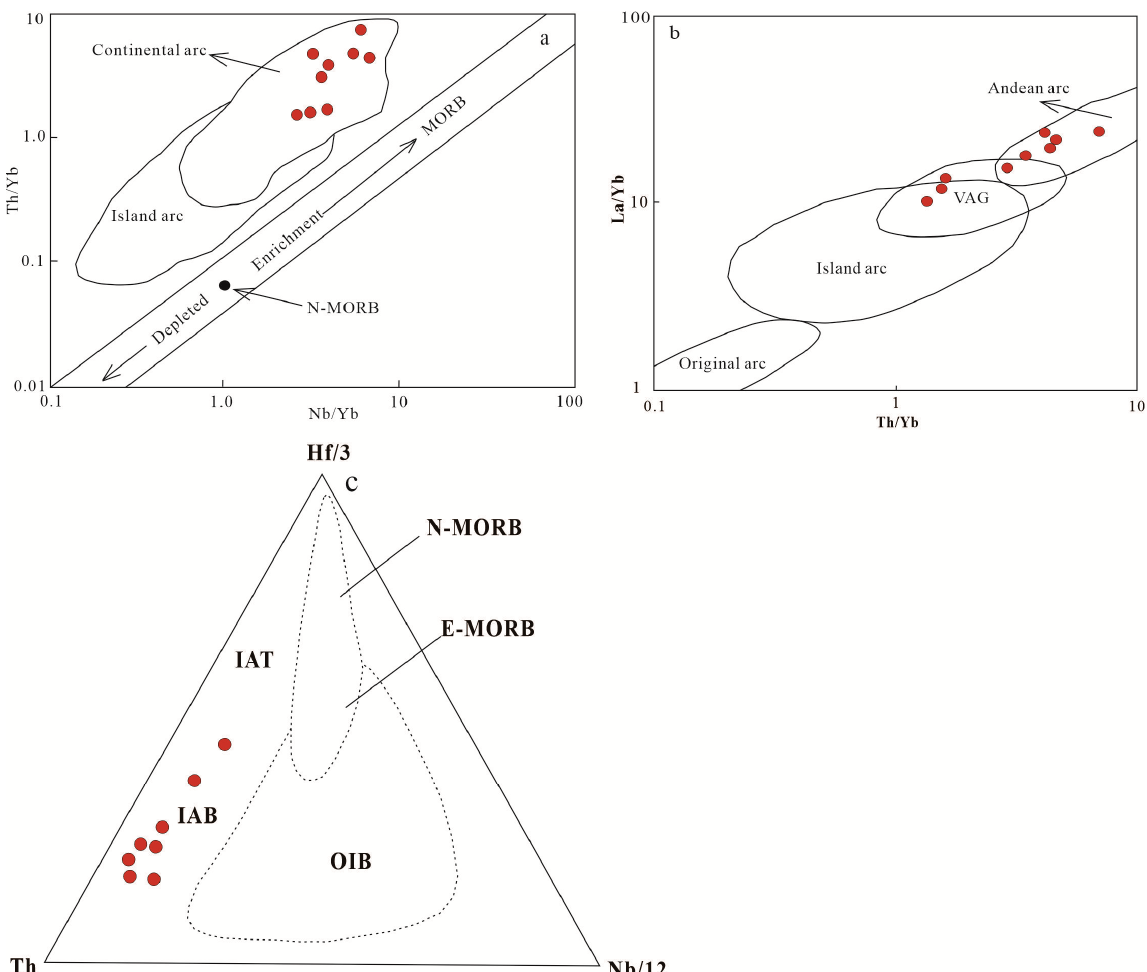
Figure 10. ( a ) Th/Yb vs. Nb/Yb diagram (modified after Li et al. [67]). ( b ) La/Yb vs. Th/Yb diagram (modified after Bailey [68]) mafic volcanic in Badaguan area. ( c ) Classical discriminant diagram Hf/3-Th-Nb/12 (modified after Wood [69]). MORB: mid ocean ridge basalt.